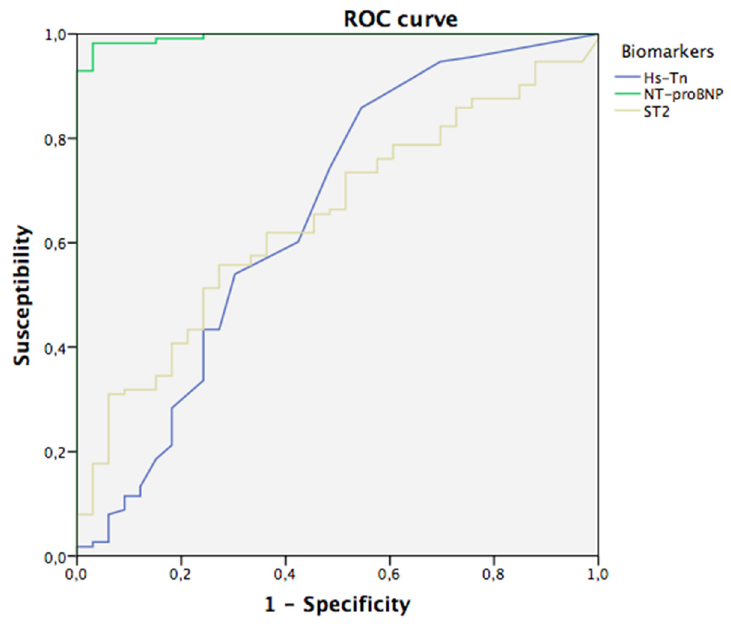
Figure 1. ROC curves. Hs-Tn: High sensitivity troponin.